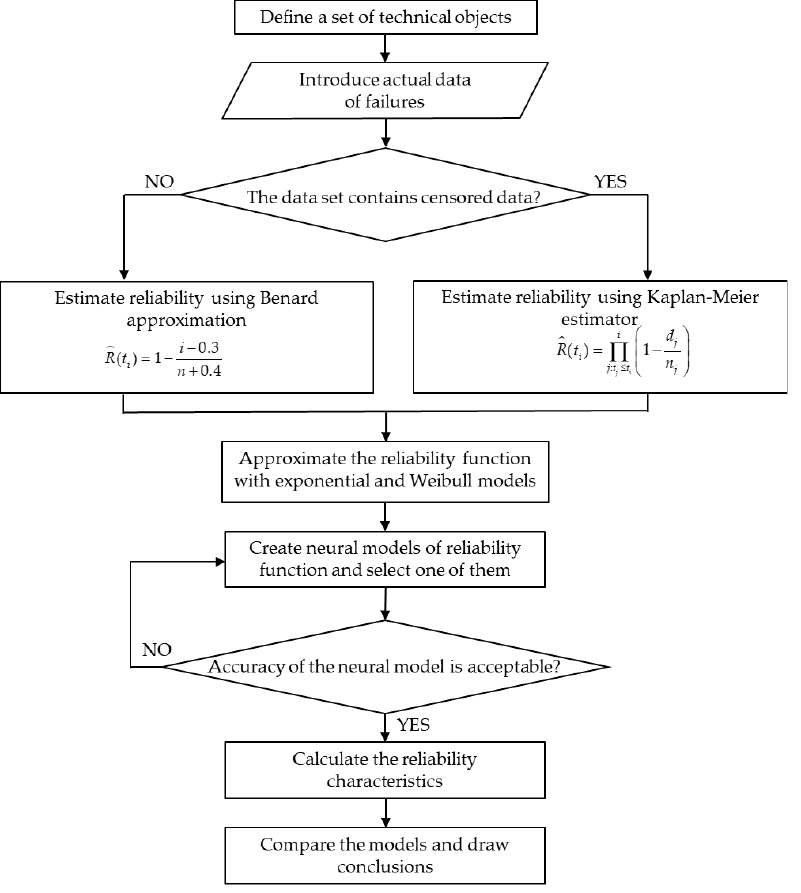
Figure 1. Flowchart of reliability modelling.